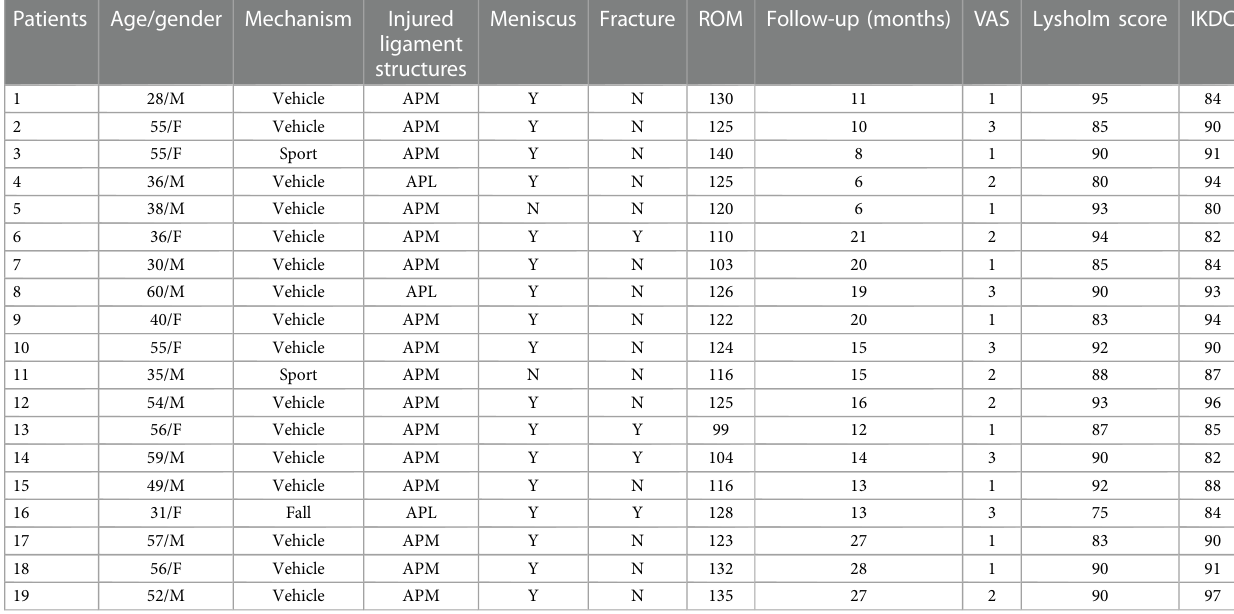
TABLE 1 Characteristics of patients. Patients Age/gender Mechanism Injured